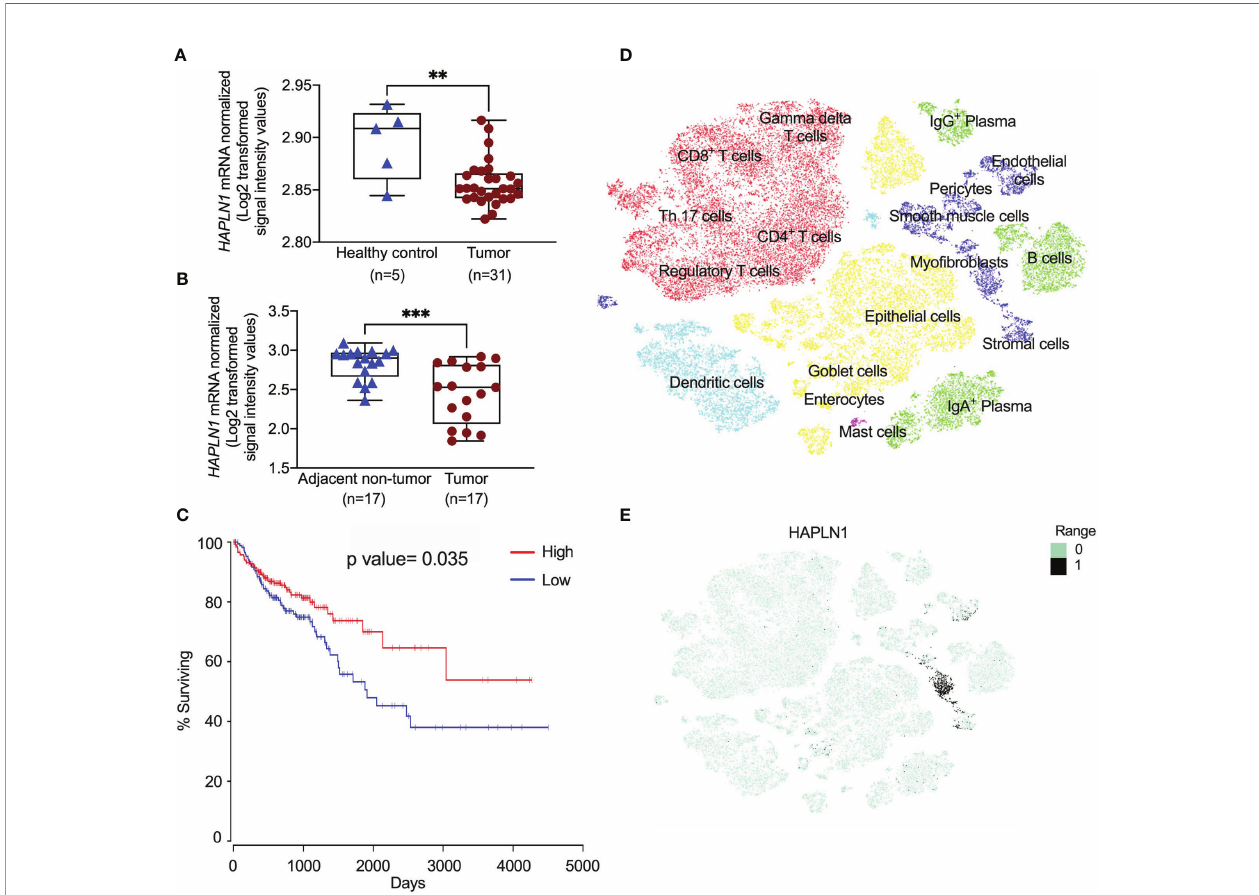
FIGURE 1 | HAPLN1 gene expression is decreased in colorectal cancer (CRC) patients. (A) HAPLN1 gene expression was analyzed in colon tissues from healthy ( n = 5) and CRC patients ( n = 31) in the GSE128449 dataset. (B) HAPLN1 gene expression was analyzed in colon tissues from tumor and normal tissue adjacent to the tumor from the same CRC patients ( n = 17) in the GSE110224 dataset. (C) The Kaplan – Meier survival curve of the correlations between the mRNA expression of the HAPLN1 gene and survival days, and the cutoff value of RNA expression was 27.8. (D) Single cells were isolated from tumors in CRC patients ( n = 31) after surgery. Cells were clustered using a graph-based shared nearest neighbor clustering approach and visualized in a t -distributed stochastic neighbor embedding (tSNE) plot in UCSC cell browser. (E) mRNA expression of HAPLN1 in different cells in CRC patients. Results are mean ± SEM. ** P < 0.01, *** P < 0.001 compared with healthy control or non-tumor adjacent